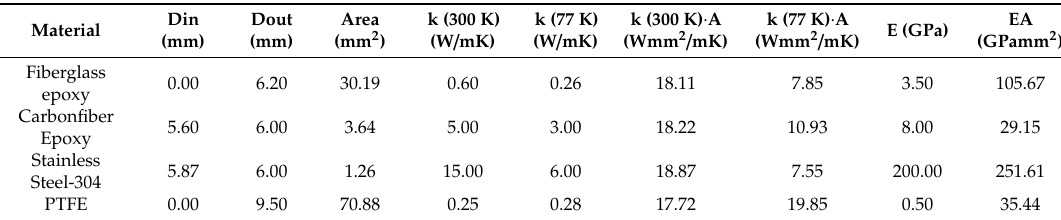
Table 1. Trade-o ff analysis: Rigidity versus thermal